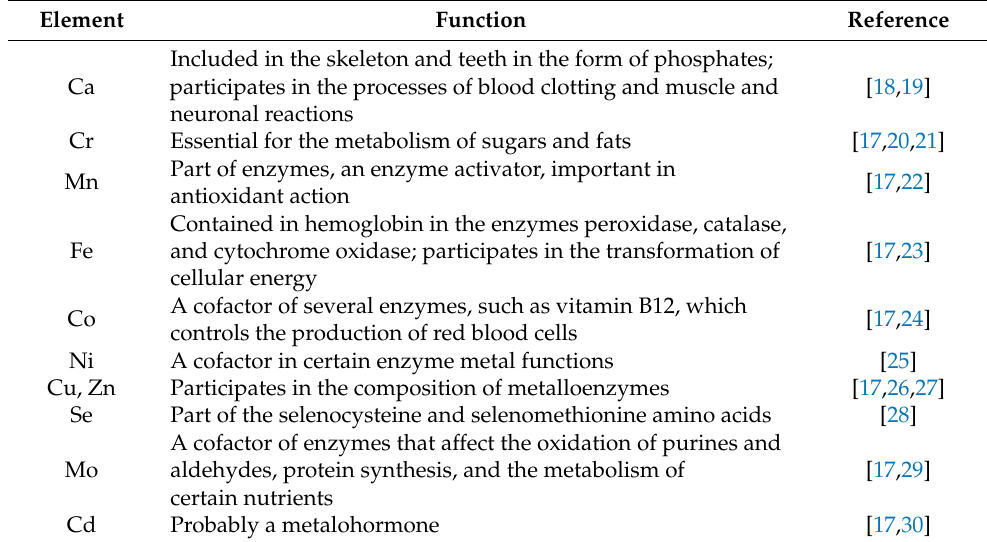
[18,19] [17,22] [17,23] [17,24] [17,29]